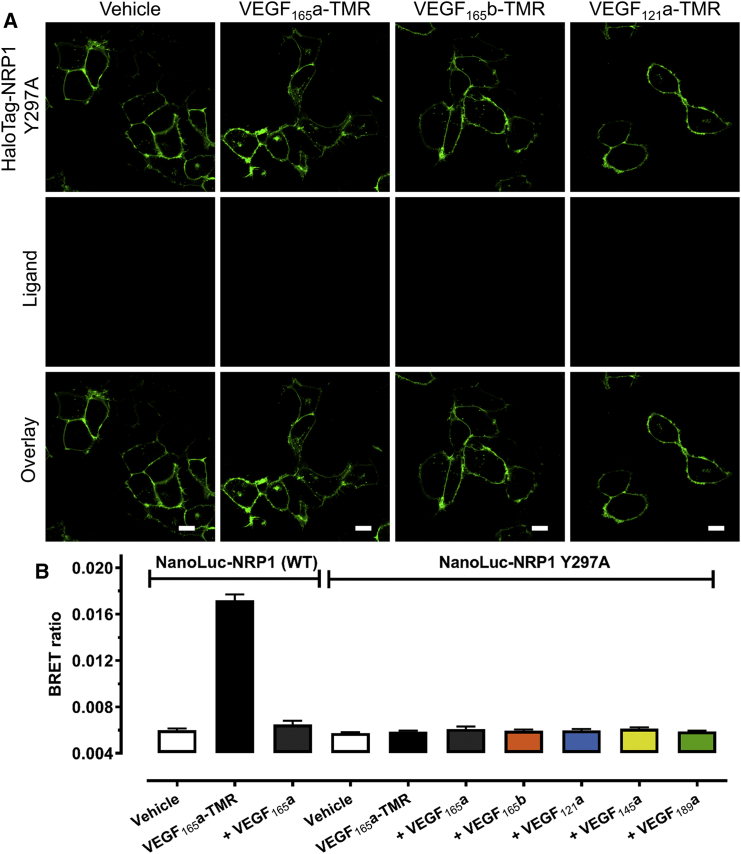
The NRP1 Mutant Y297A Is Unable to Bind Any VEGF Isoforms(A) Live confocal imaging of HEK293T cells stably expressing mutant HaloTag-NRP1 Y297A (green) labeled with membrane-impermeant HaloTag-AF488 dye (green). Cells were stimulated with 10 nM VEGF165a-TMR, VEGF165b-TMR, or VEGF121a-TMR for 60 min at 37°C. Cells were imaged using an LSM710 confocal microscope, and images are representative images of 3 independent experiments. Scale bar, 10 μm.(B) NanoBRET measurements of the effect of unlabeled VEGF isoforms (30 nM) on the binding of 3 nM VEGF165a-TMR to wild-type NanoLuc-NRP1 or NanoLuc-NRP1 Y297A stably expressing HEK293T for 60 min (37°C). Raw BRET ratios are expressed as mean ± SEM pooled from 4 independent experiments.